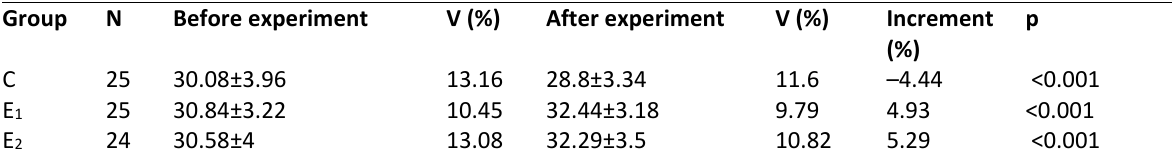
Table 1. Dynamic of mental processes’ quickness and mind operations’ efficiency of economic specialties’ girl students in the course of pedagogic experiment (n=74) Group